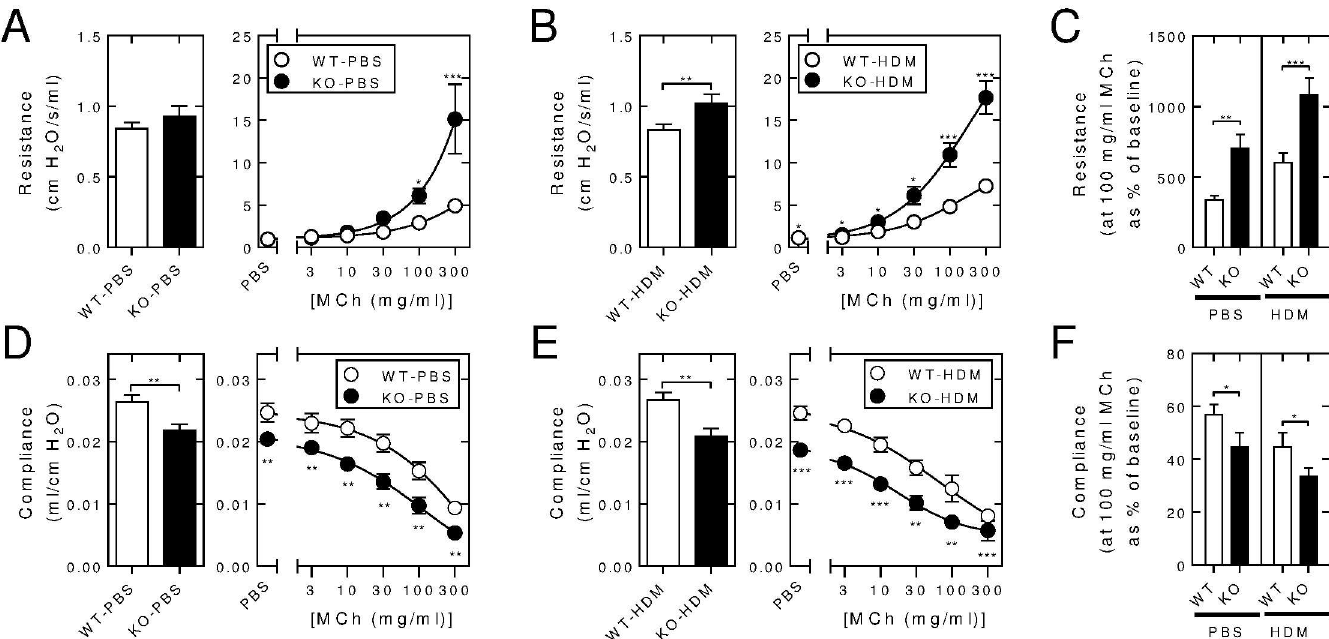
Fig 2. Comparison of lung function between wild type and Rgs2 -/- mice following i . n . instillation of either PBS or HDM. Wild type (WT) and Rgs2 -/- (KO) mice were subjectedto i . n . instillation of PBS (25 μ l), 3 times/week for 3 weeks after which lung function was measuredusing a Flexivent apparatus. A, Airways resistance (cm H 2 0/s/ml) and, D, compliance(ml/cm H 2 O) are shown at base line (left panels)and followinginhaledchallengewith PBS or increasing concentrations of methacholine (MCh) as indicated.Data ( N = 16 for wild type and 15 for Rgs2 -/- ) are plotted as means ± SE. Wild type and Rgs2 -/- mice were subjectedto i . n exposureto HDM (25 μ g) 3 times/week prior to lung function analysis. B, resistanceand, E, compliance at baselineand followinginhaledchallenge with PBS or increasingconcentrations of MCh as indicatedare shown. Data ( N = 27 for wild type and 20 for Rgs2 -/- ) are plotted as mean ± SE. For each animal,resistanceand compliancemeasurements were expressedas a percentage of baseline. C, Resistance and, F, compliance data from panelsA, B, D and E are shown for 100 mg/ml MCh as a percentageof baselineand plotted as means ± SE. Significance was tested betweenwild type and Rgs2 -/- groups by unpairedMann Whitney U test. * P < 0.05, ** P < 0.01, *** P <